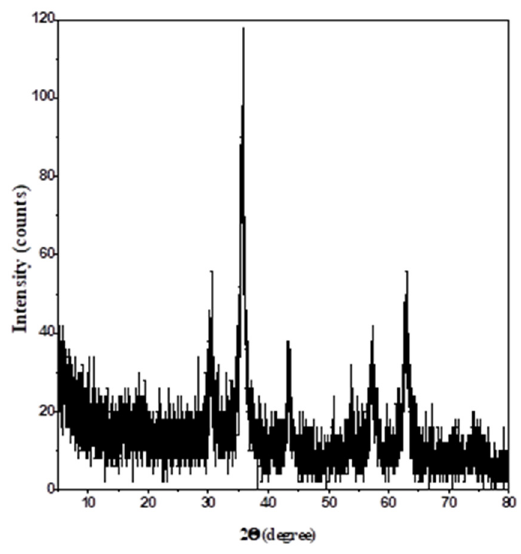
Figure 4. XRD pattern for GA/MNPs.